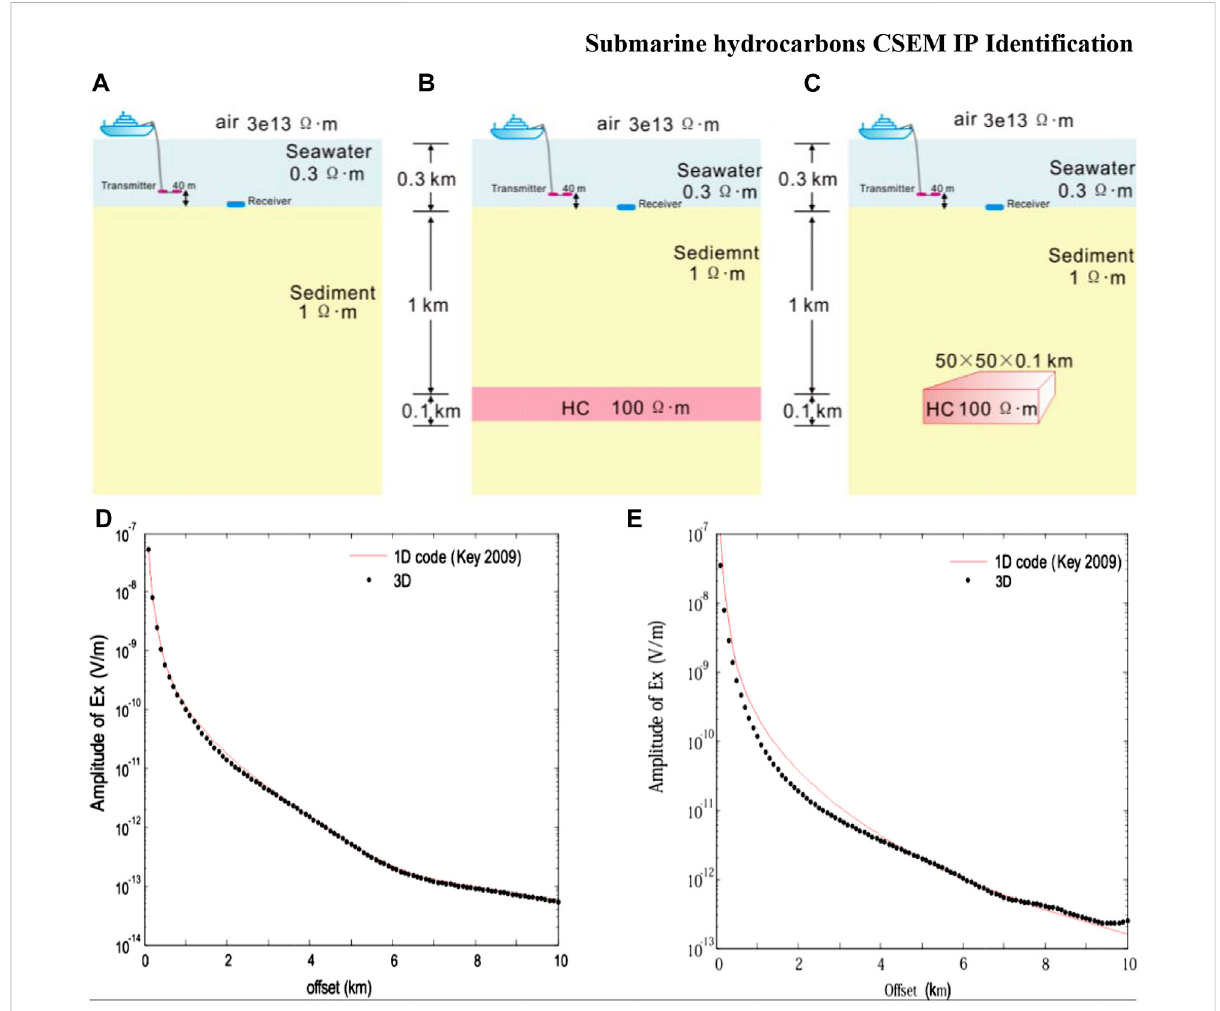
FIGURE 4 GeoelectricmodelofHCandcorrespondingforwardcalculation Exversusoffsetinthe1Dandthe3DmarineCSEM. (A) 1Dmodelwithsea fl oor depth = 0.3 km; (B) 1D model with HC below sea fl oor = 1 km; (C) 3D model with HC below sea fl oor = 1 km and the size = 50 × 50 × 0.1 km 3 ; (D) calculated magnitude of electric fi elds Ex versus offset (km) from the 1D and the 3D model without HC in (A,B) ; (E) calculated magnitude of electric fi elds Ex versus offset (km) from the 1D and the 3D model with HC in (C)